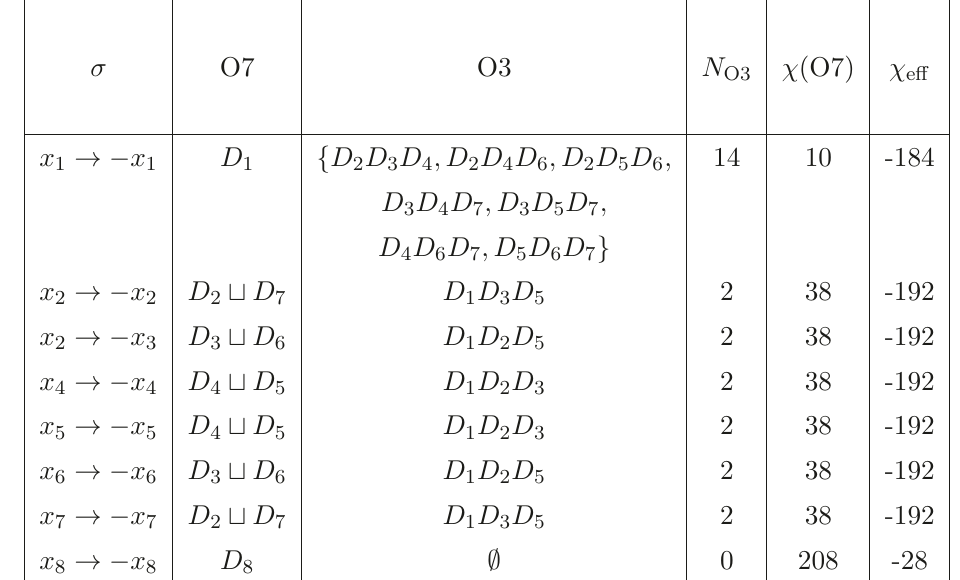
Table 3 . Fixed point set for the involutions which are reflections of the eight coordinates x i = 1 , . . . ,